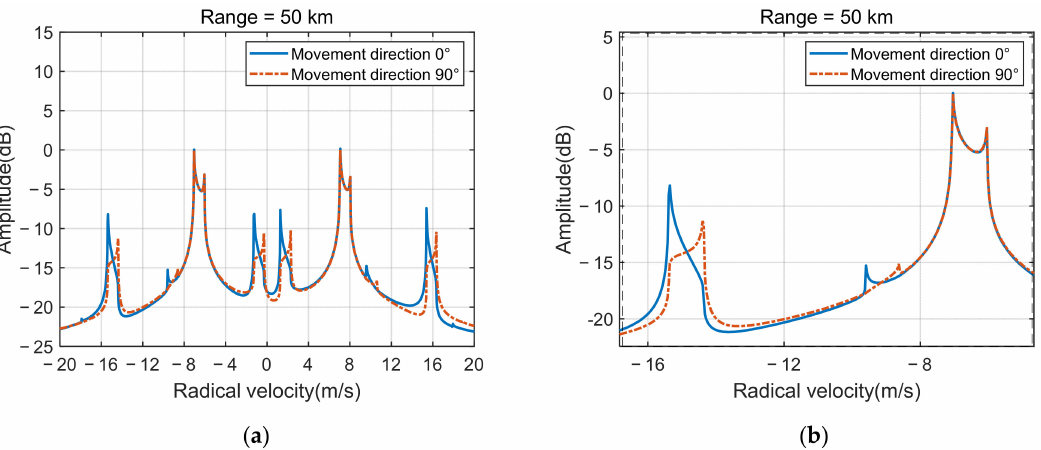
Figure 10. Simulated first-order RCS with periodic oscillation motion and uniform linear motion. ( a ) First-order Doppler spectra of two oscillation directions. ( b ) Zoomed-in view of the first-order Doppler spectra in ( a